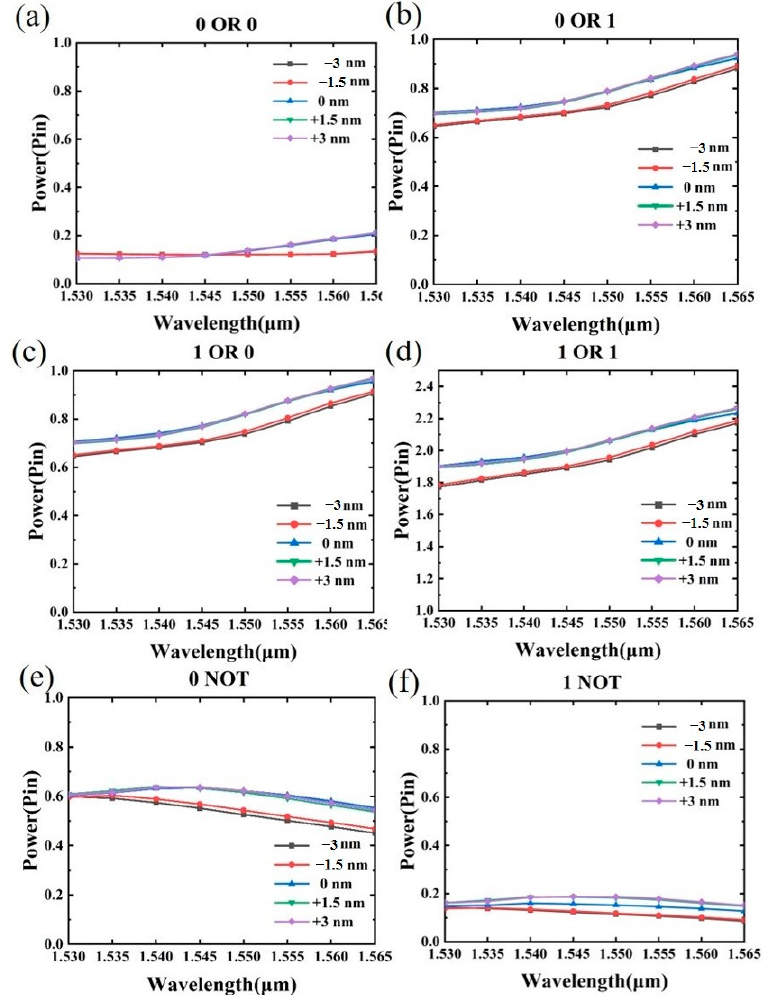
Figure 7. Analysis of manufacturing tolerances for all-optical logic gates. ( a – f ) A graph of the output optical power of OR logic gates and NOT logic gates when the phase-change material edge length varies from − 3 nm to +3 nm.